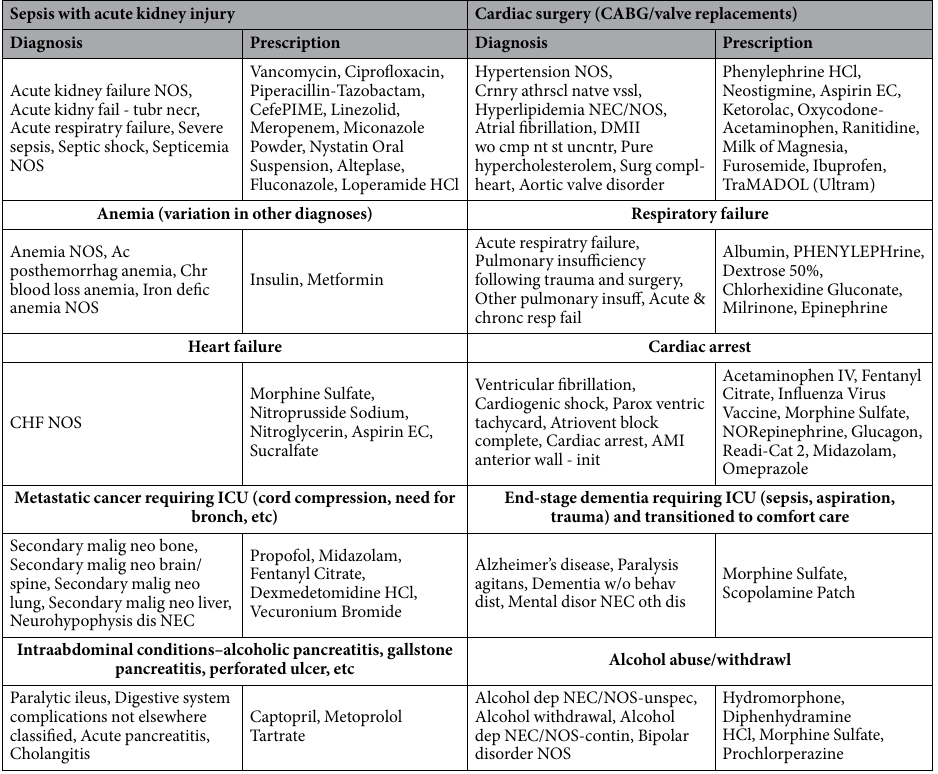
Table 4. Ten representative phenotypes. Listed in order of frequency.